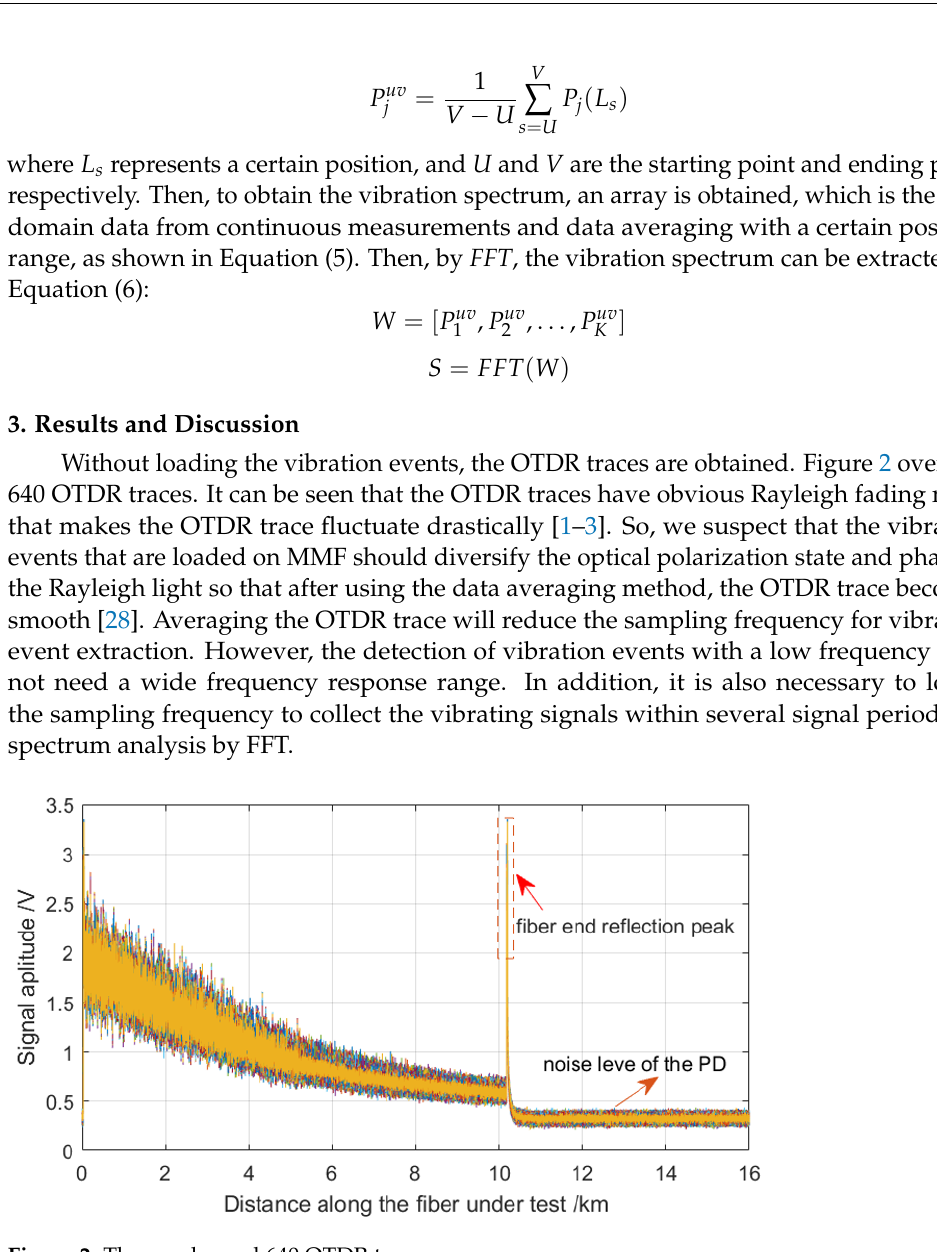
Figure 2. The overlapped 640 OTDR traces.